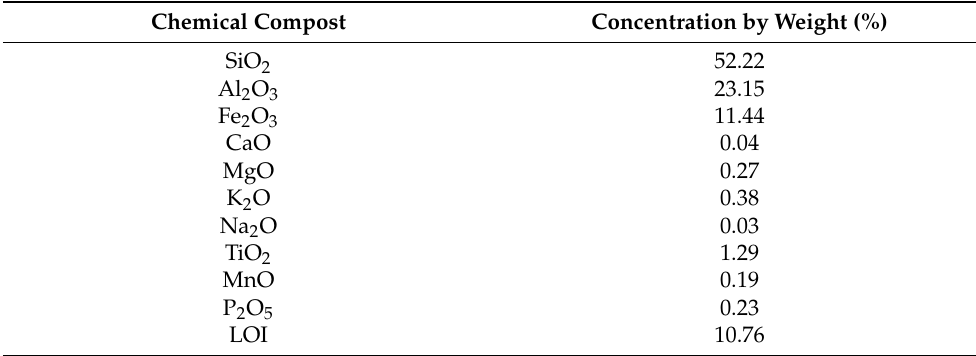
Table 2. Chemical composition of the soil